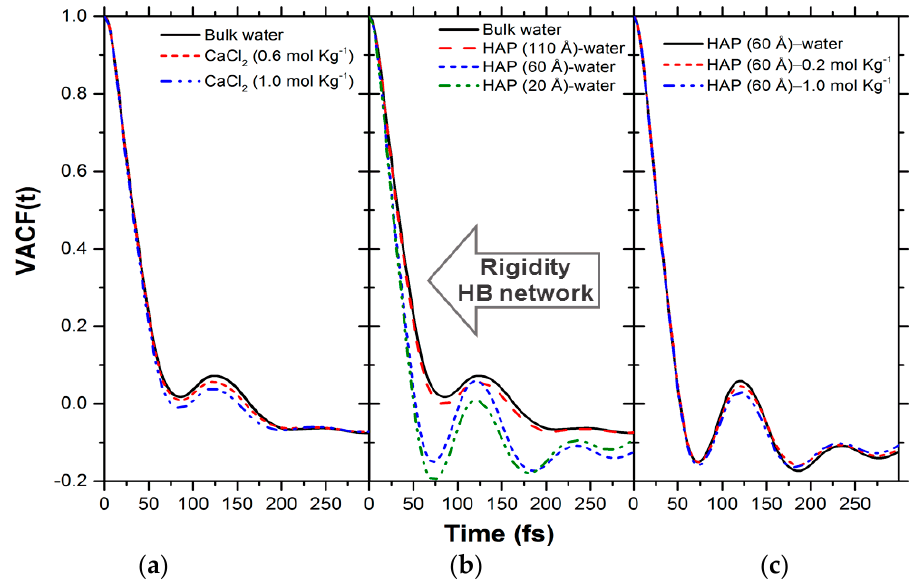
Figure 4. Velocity autocorrelation function (VACF) of the oxygen atoms of water. ( a ) Bulk water and aqueous CaCl 2 solutions. ( b ) Bulk water and water within HAP nanopores (H = 110 Å, H = 60 Å, and H = 20 Å). ( c ) CaCl 2 solutions within the HAP nanopore (H = 60 Å).